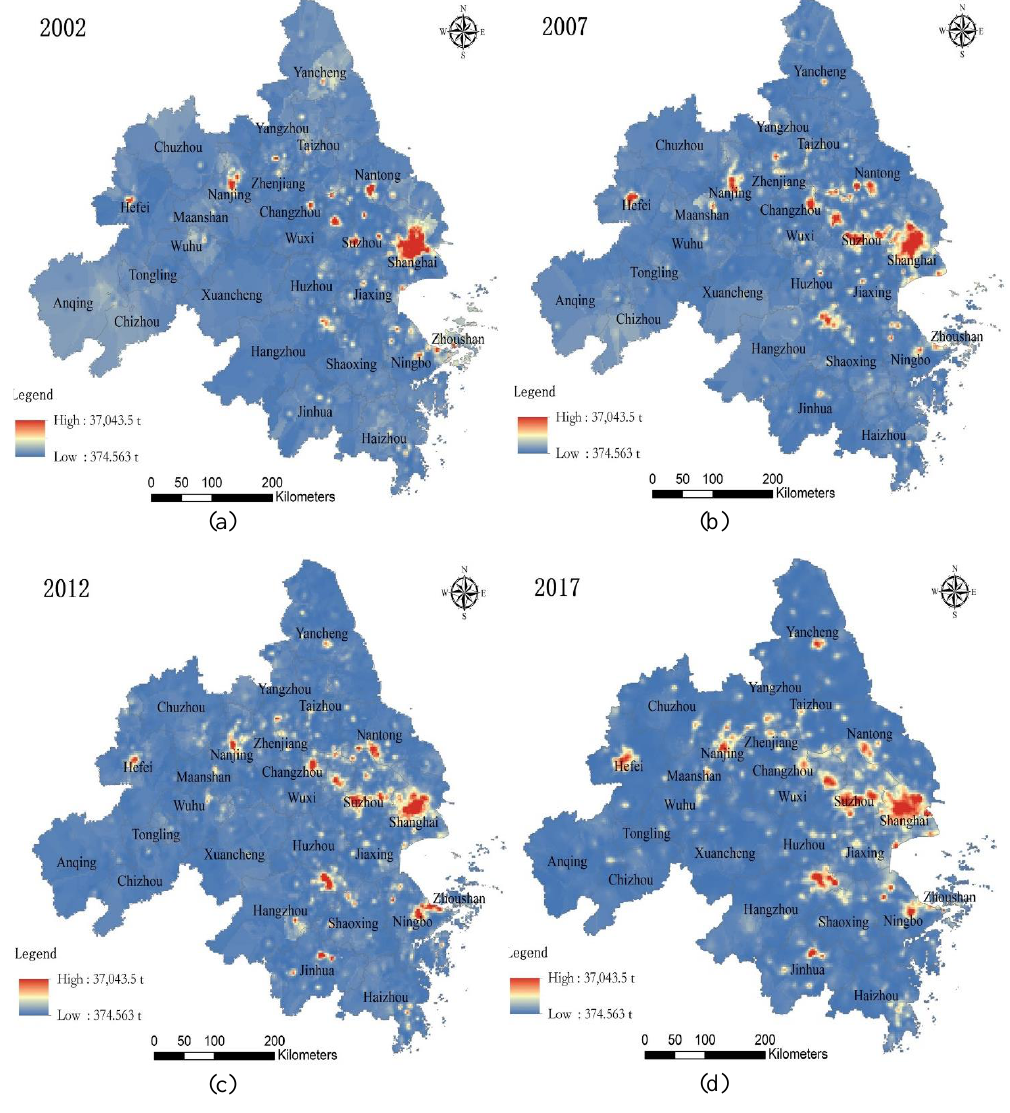
Figure 7. Distribution of CO 2 emissions in 2000 ( a ), 2007 ( b ), 2012 ( c ), and 2017 ( d ).